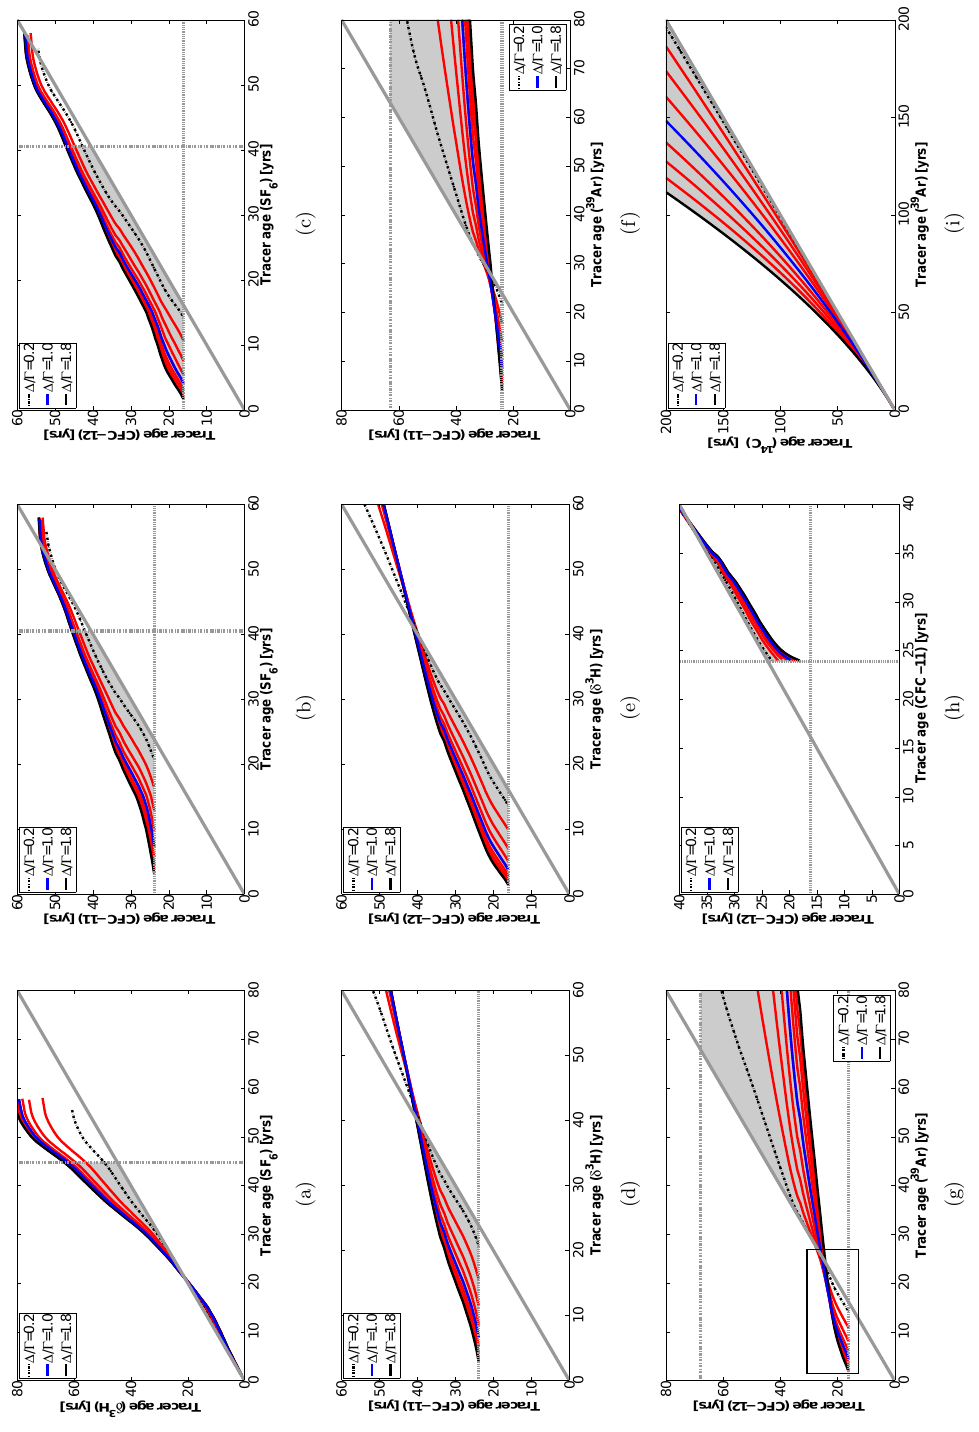
Figure 4. IG-TTD validity areas of the transient tracer couples using the tracer age relationship. The grey area describes the IG-TTD-based tracer age relationship for (cid:49)/(cid:48) ratios between 0 and 1.8 (see Sect. 3 for an explanation). Consequently, the boundaries are the bisecting line (grey solid line) with (cid:49)/(cid:48) = 0, i.e., where both tracer ages are equal, the detection and atmospheric concentration limit of the tracer (dashed and dash dotted grey lines, respectively) and the IG-TTD-based tracer age relationship of (cid:49)/(cid:48) = 1 . 8 (black solid line). The red solid lines indicate a (cid:49)/(cid:48) -ratio increment of 0 . 2. The tracer couples are (a) δ 3 H/SF 6 , (b) CFC-11/SF 6 , (c) CFC-12/SF 6 , (d) CFC-11/ δ 3 H, (e) CFC-12/ δ 3 H, (f) CFC-11/ 39 Ar, (g) CFC-12/ 39 Ar, (h) CFC-12/CFC-11 and (i) 39 Ar/ (cid:49) 14 C. Areas with intercepting (cid:49)/(cid:48) isolines (black box in g ) are indistinct in tracer age and thus